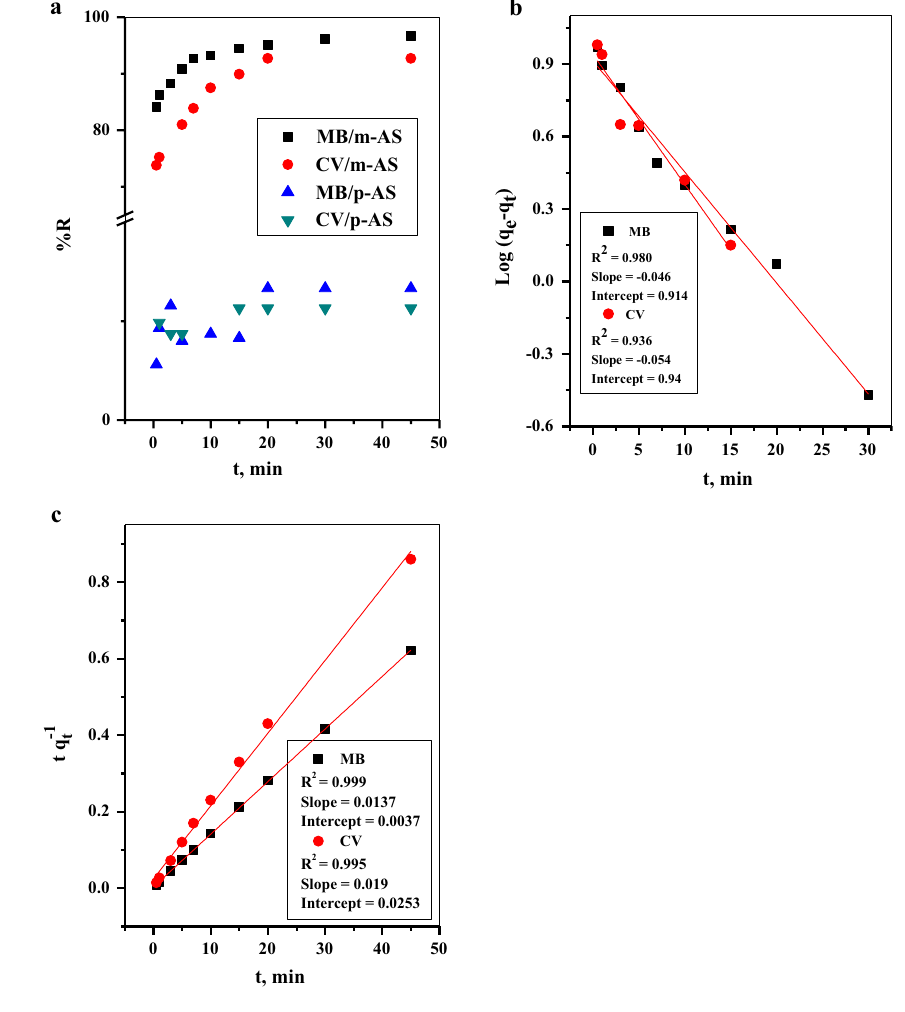
Fig. 7 a Effect of contact time on removal percent of MB and CV dyes, b Lagergren plots for removal of MB and CV dyes and c pseudo-second-order plot for removal of MB and CV dyes from pure water by m-Bio- char. MB → [MB] = 60 ppm, dose = 0.04 g, T = 25 °C, pH = 7, V = 50